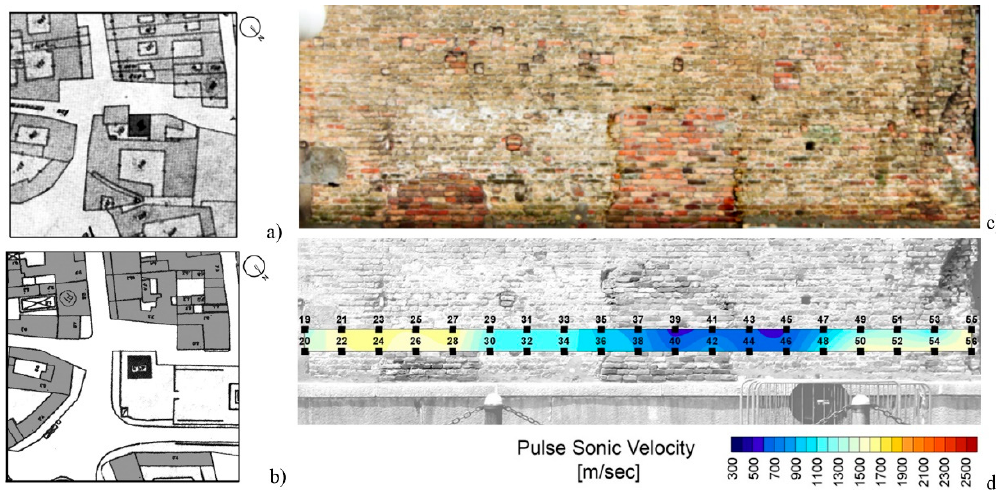
Figure 12. Layout of the Isso Tower area in a map of Castelleone dated back to 1901 ( a ) and recent one ( b ) where the tower appears isolated; the surrounding buildings were demolished but their presence explains the presence of infilled openings and other irregularities of the masonry texture ( c ). Pulse sonic velocity test ( d ) confirmed lower compactness materials. The numbers in ( d ) are the acquisition points [32].